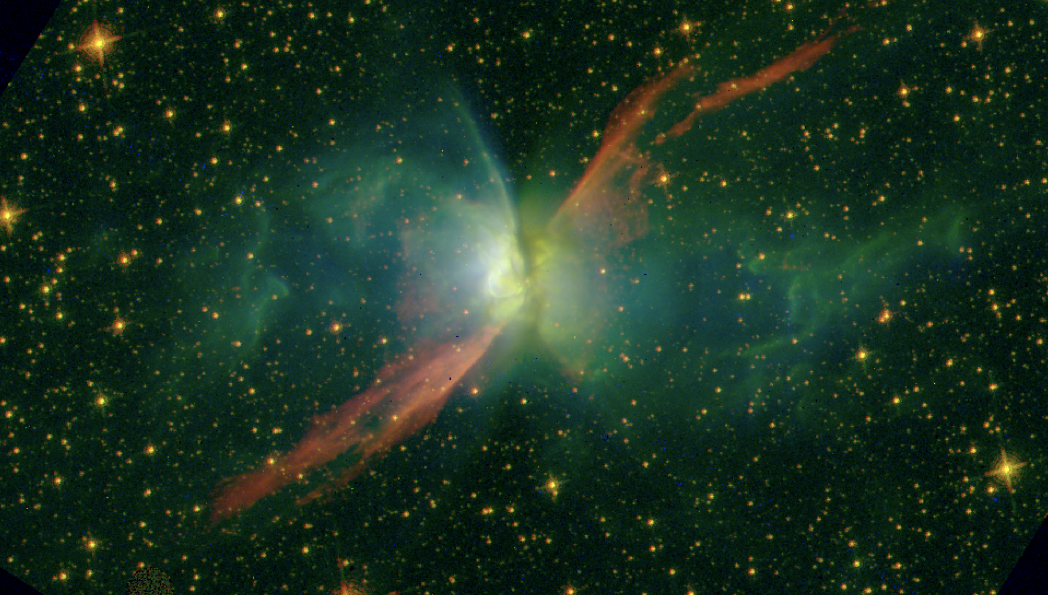
Figure 2. Color overlay of Cycle 27 HST/WFC3 narrow-band images of NGC 6302. Filter F343N ([Ne V ]) is blue, F128N (Pa β ) is green, and F164N ([Fe II ]) is red. The field of view is ∼ 120 (cid:48)(cid:48) × 70 (cid:48)(cid:48) ; north is up and east is to the